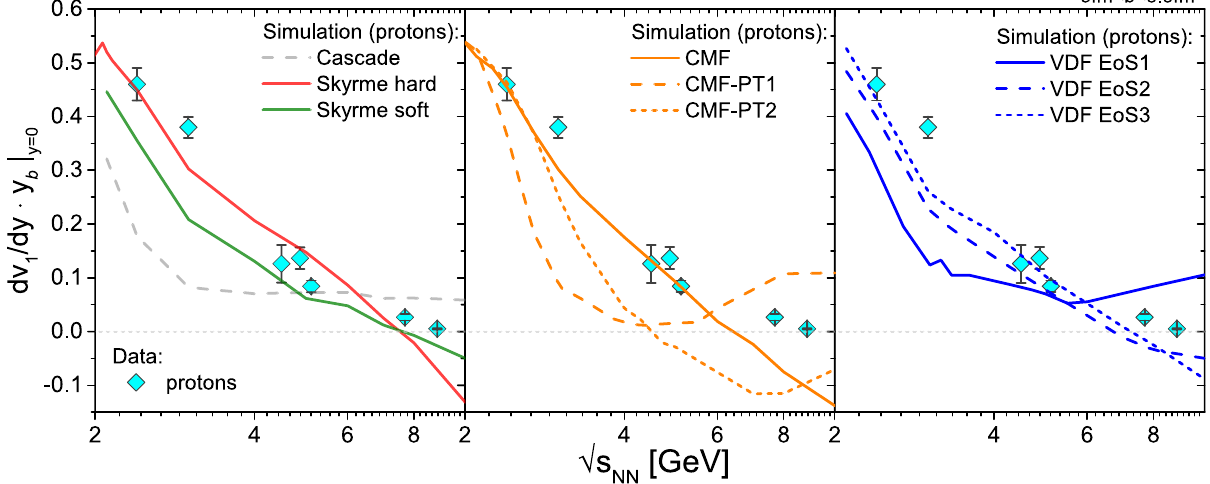
Fig. 5 The slope of the directed flow, d v 1 / dy b ≡ d v 1 / dy · y b ( y is the proton rapidity in the center of mass frame of the collision, i.e. y cm = 0, and y b is the beam rapidity defined in the center-of-mass frame of the collision), for mid-central Au–Au collisions (5 < b < 8 . 3 fm). The slope is evaluated at mid-rapidity | y / y b | < 0 . 1 and no cut in the trans-